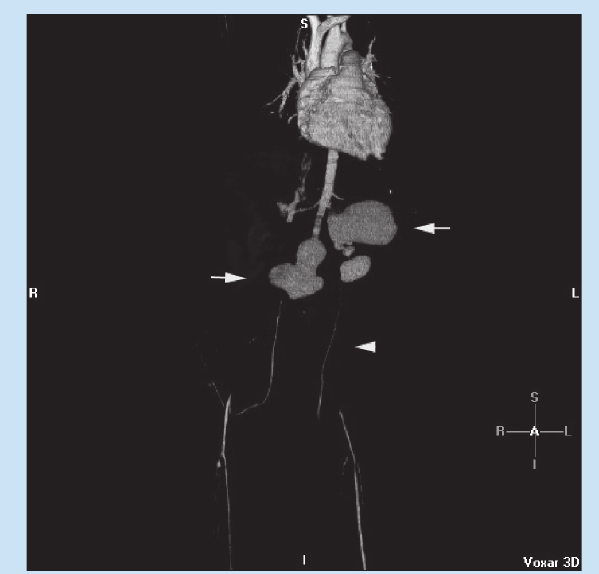
Fig. 1. CT angiogram of thorax and abdomen, surface shaded display. The abdominal aortic aneurysm is seen in the midline and the superior mesenteric artery aneurysm on the left (arrows). The iliac arteries are occluded with reconstitution of the common femoral arteries via col- lateral vessels (arrowhead).